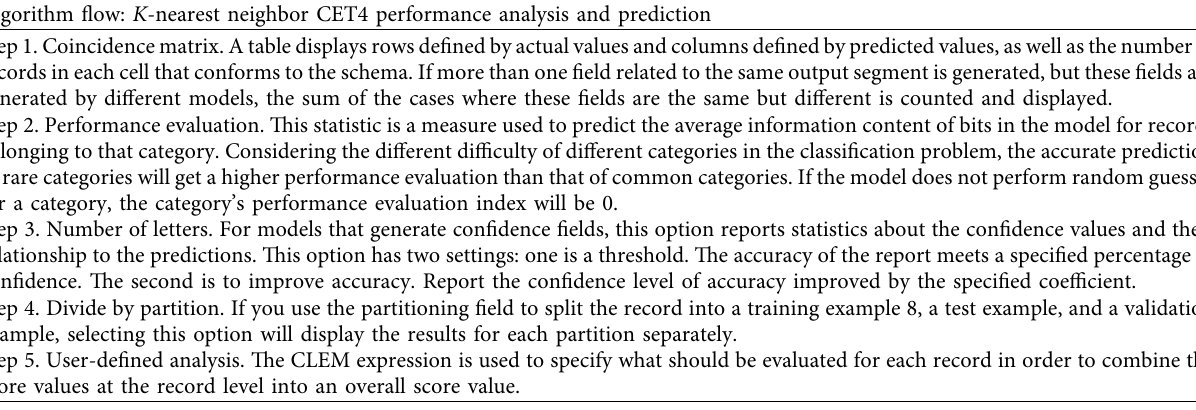
Table 2: K -nearest neighbor CET4 performance analysis and prediction algorithm flow. Algorithm flow: K -nearest neighbor CET4 performance analysis and